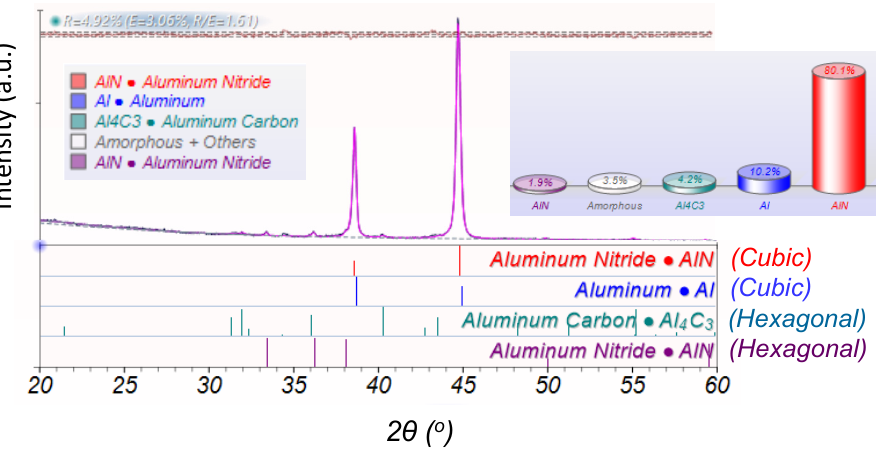
Figure 8. A typical result from the Rietveld quantitative analysis of a plasma synthesized sample. Table 6. Measured amount of the various phases in the plasma-synthesized coatings by RQA using XRD data. Phase Concentration in the Coatings Synthesis Parameters